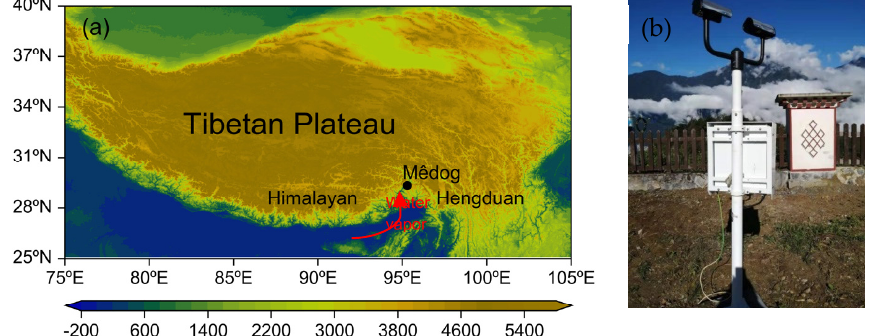
Figure 2. The locations of Mêdog (black solid dot) and Yarlung Zangbo Grand Canyon (YGC), and topography (m) of the Tibetan Plateau (TP) ( a ) and the PARSIVEL disdrometer ( b ). The red arrow indicates water vapor channel in the YGC.